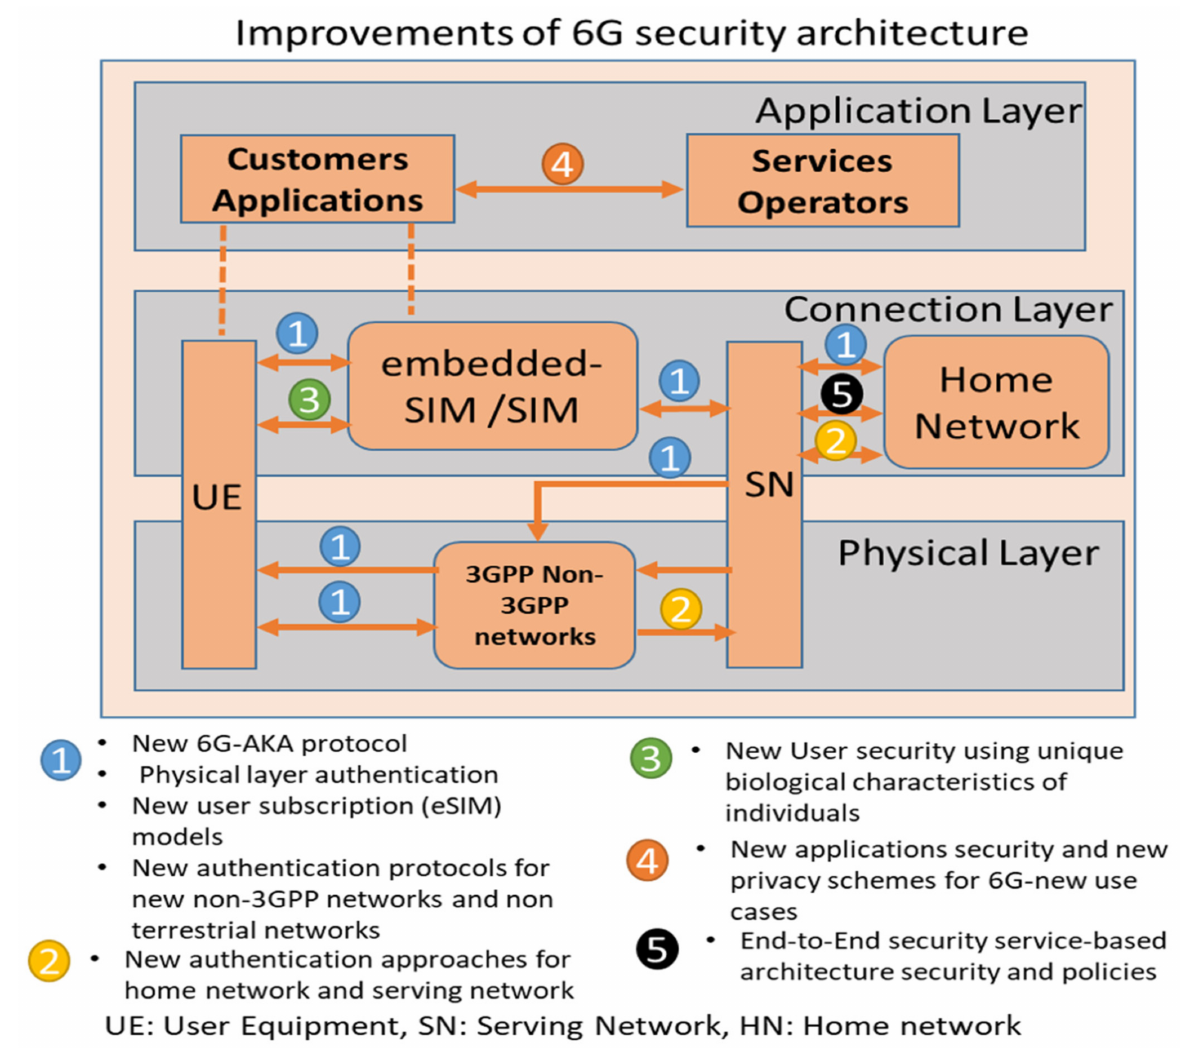
Figure 3. The expected improvements and changes in the 6G security